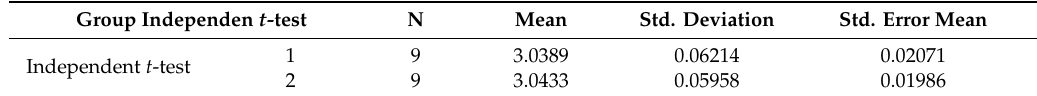
Table 11. Group statistic independent t -test.